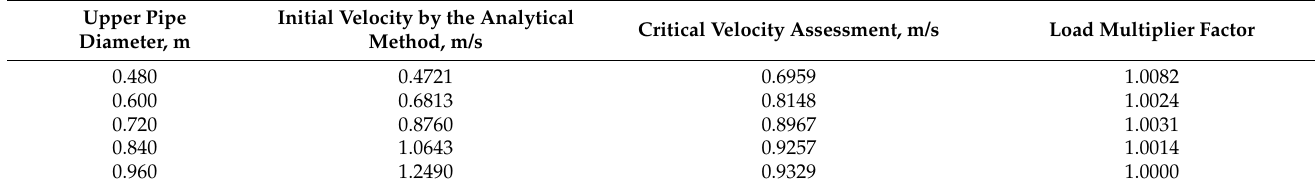
Table 6. The effect of the floatation pipe diameter on the critical velocity, for the Drift State.